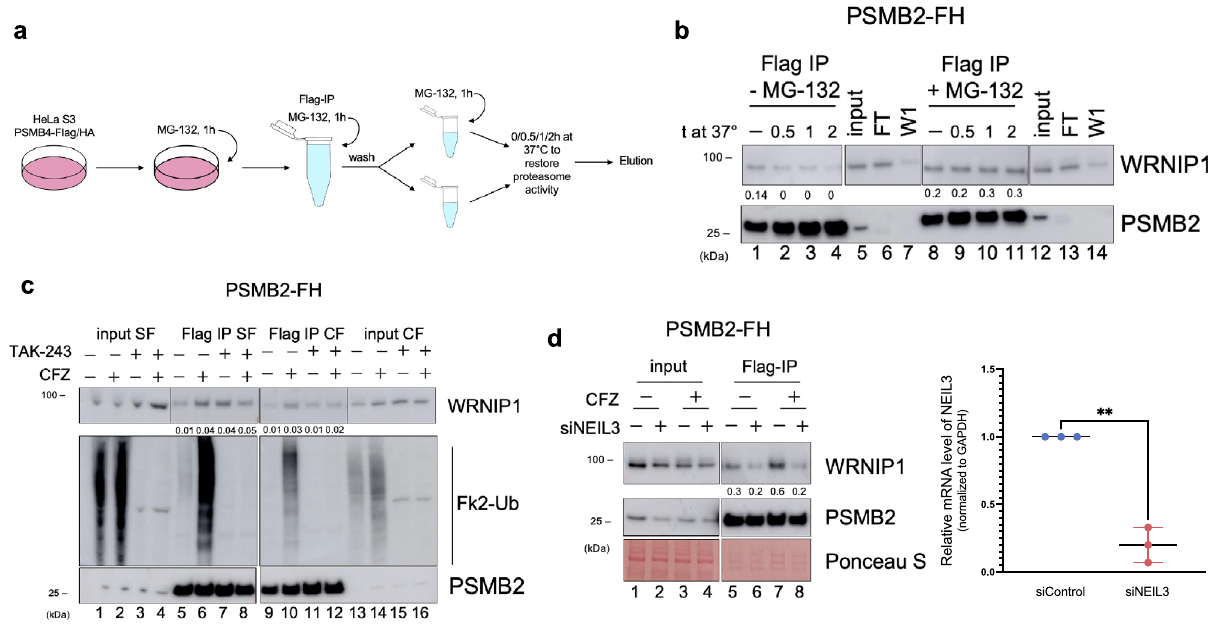
Figure 4. WRNIP1 is degraded in the ubiquitin-proteasome pathway. ( a ) Schematic outline of the experiment shown in panel “b”. ( b ) Western blot of Flag IP samples purified from PSMB2-FH cells treated with MG-132 as depicted in panel “a”. ( c ) Western blot of Flag IP samples purified from HeLa S3 PSMB2-FH cells treated with broad ubiquitylation inhibitor TAK-243 and carfilzomib. ( d ) Effect of NEIL3 knockdown on WRNIP1 degradation. Left, Western blot of Flag IP samples purified from PSMB2-FH cells treated with cisplatin, CFZ, and NEIL3 siRNA; Right, confirmation of NEIL3 knockdown by RT-qPCR. Data shown are the mean ± SD (n = 3). ** p < 0.01. Note that the membranes were cropped to remove overexposed parts. CF, chromatin fraction; SF, soluble fraction that contains cytoplasmic and nuclear proteins; FT, flow-through; W1, first wash of the beads. IP experiments were normalized by Flag/HA tagged protein used as a bait and quantified using ImageJ software. Ratios for each protein are indicated below the given blot. See Materials and Methods for additional